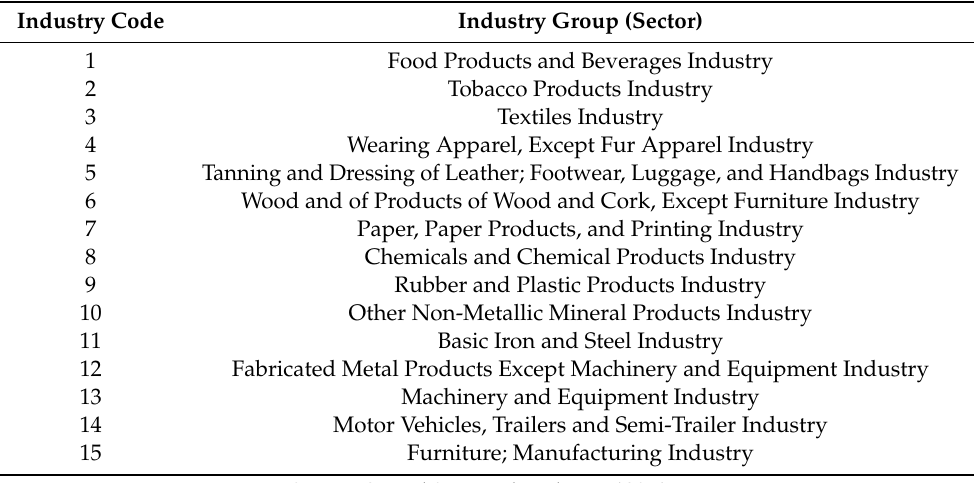
Table 1. List of industry